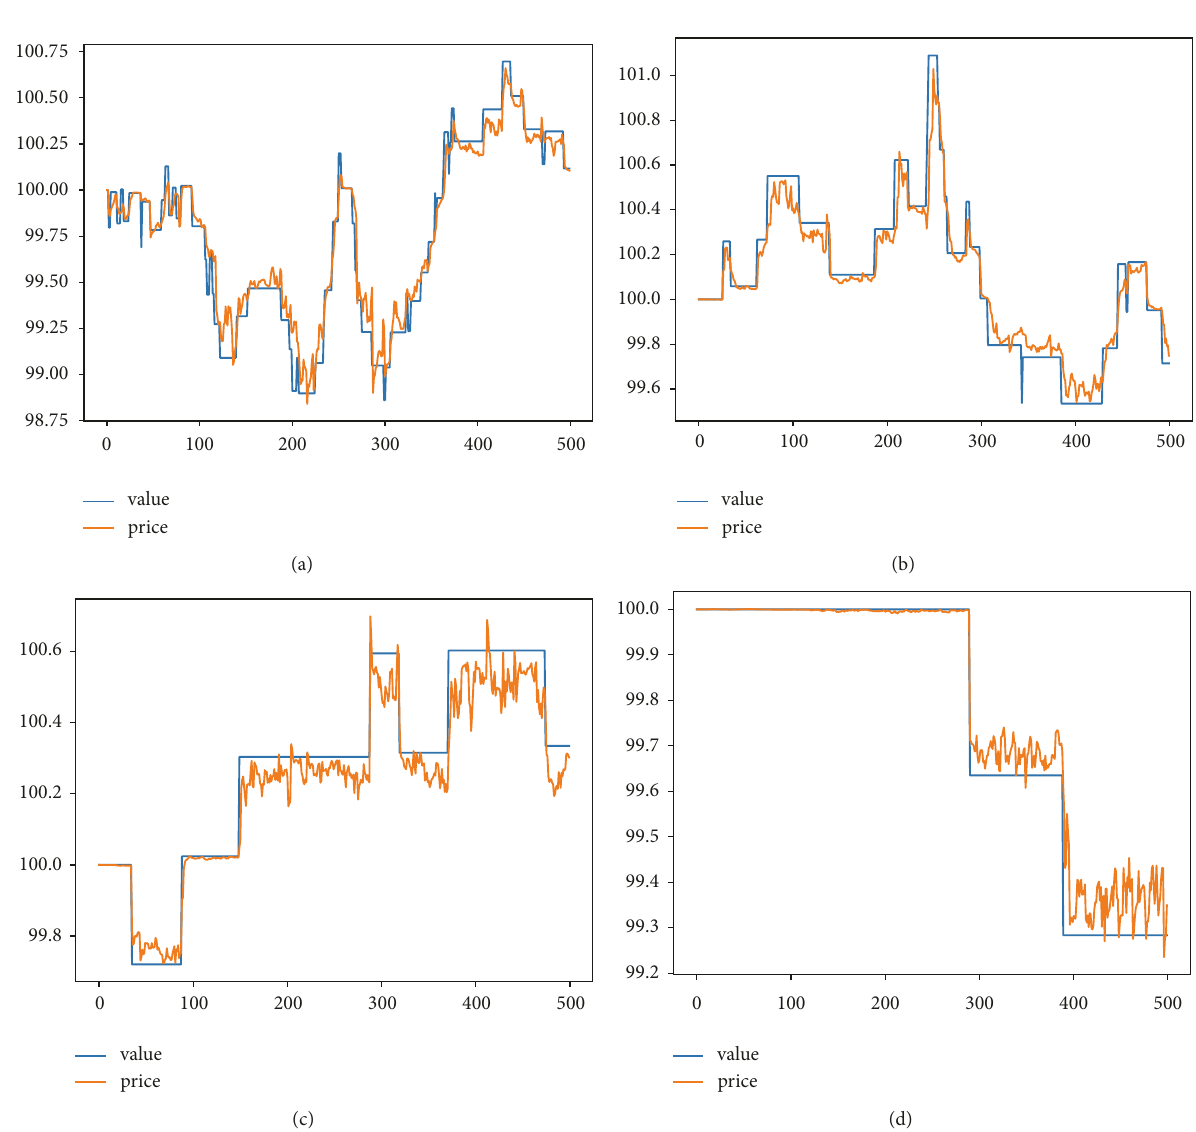
Figure 6: Simulation results of price series and value series under different thresholds . (a) The trajectory of price and value with a threshold of 1.5. (b) The trajectory of price and value with a threshold of 2. (c) The trajectory of price and value with a threshold of 2.5. (d) The trajectory of price and value with a threshold of